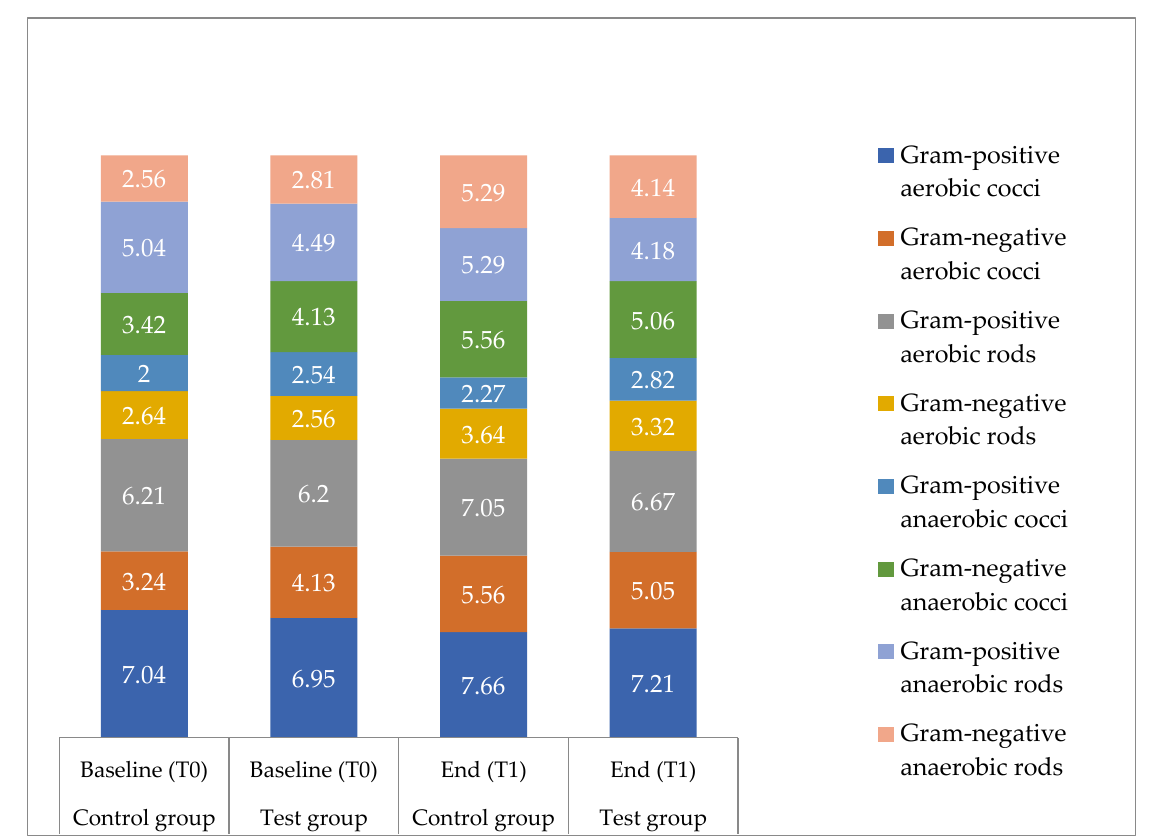
Figure 2. Subgroups of bacterial species detected in saliva. Bacterial counts of subgroups of bacterial species for the test group and the control group at baseline (T0) and after 36 months (T1); values are given as means in log10 CFU/mL; n = 16 for each group.